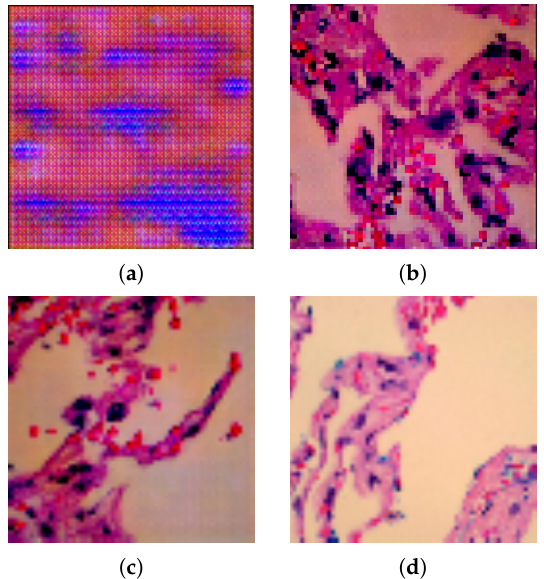
Figure 3. Synthetic lung benign images generated from the different version of LCGAN: ( a ) image from the initial version of LCGAN, ( b ) image from LCGAN which applies avoiding checkerboard methods, ( c ) image from LCGAN which applies all the proposed settings, ( d ) image from original